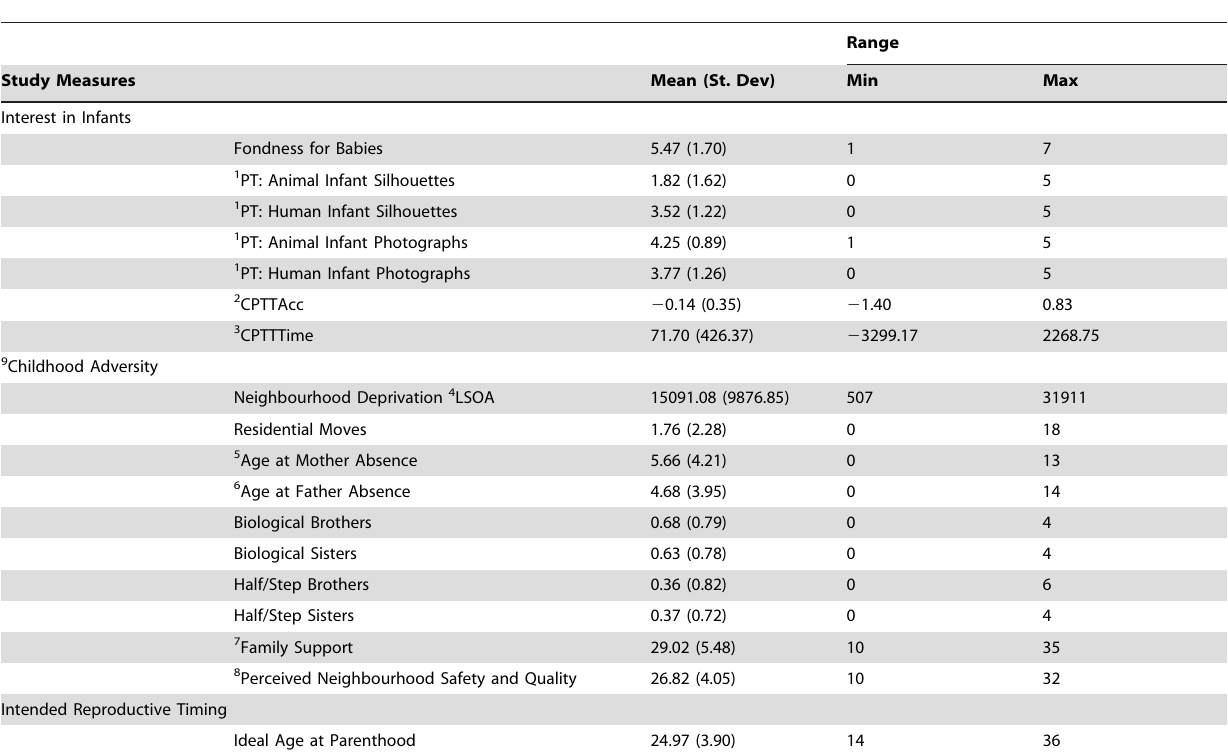
Table 2. Descriptive statistics for the study